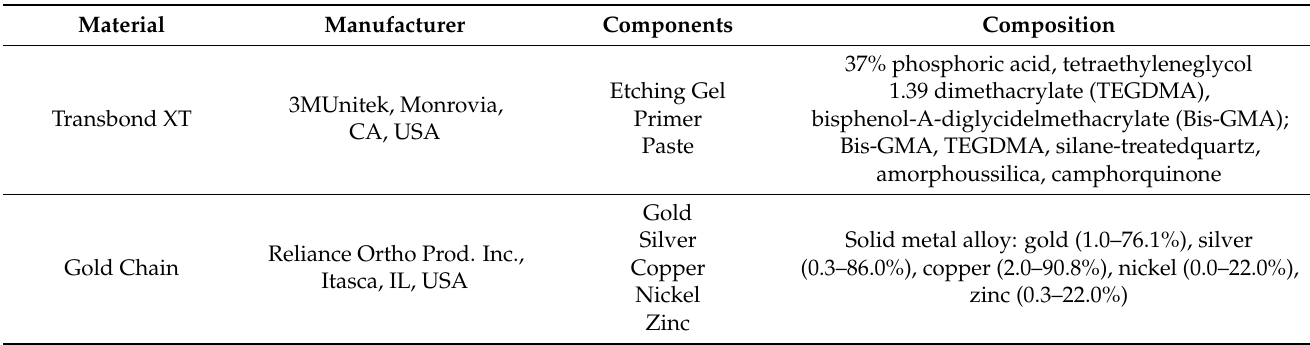
Table 1. Composition of fixed retention materials for all groups.